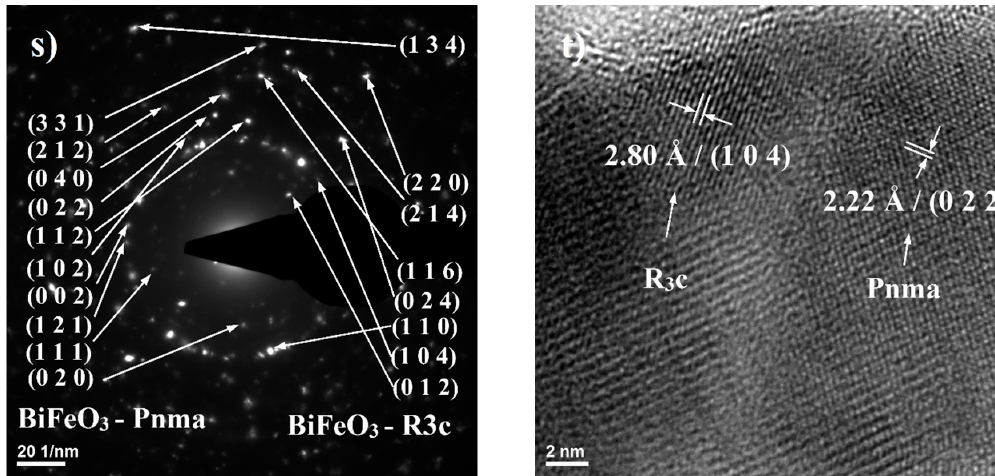
Figure 9. ( a , e , i , m , q ) Bright field TEM images, ( b , f , j , n , r ) particle size distributions, ( c , g , k , o , s ) Selected area electron diffraction patterns, and ( d , h , l , p , t ) High resolution TEM images corresponding to Bi 1 − x Eu x FeO 3 powders for: x = 0 ( a – d ), 0.05 ( e – h ), 0.10 ( i – l ), 0.15 ( m – p ) and 0.20 ( q – t ), respectively.